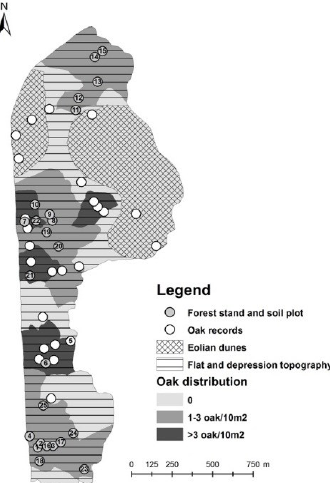
Figure 3. Distribution of study sampling sites and areas with oak saplings within the Vecdaugava forest. The forest floor was generally densely covered with vegetation. The plant communities in gaps were dominated by Calluna vulgaris (L.) Hull, Vaccinium myrtillus L. and Vaccinium vitis-idaea L. (mean 24.0%, 8.4% and 6.5% of gap area, respectively). V. myrtillus and V. vitis-idaea dominated in control plots (mean 16.5% and 10.7%, respectively). Hylocomium splendens (Hedw.) Schimp and Pleurozium schreberi (Willd.ex Brid.) Mitt. (mean 24.5% and 42.0% in gaps and 21.0% and 44.3% in control plots, respectively) were the dominant moss species. The most common graminoid species was Deschampsia flexuosa (L.) (mean 8.0% in gaps and 4.5% in control plots), and the most dominant herb species was Melampyrum pratense (L.) (mean 10.0% in gaps and 9.2% in control plots) . Figure 4 shows a DCA ordination of vegetation data, with vectors indicating significant correlations of species with the axes. The DCA ordination indicates that the gradient from top to bottom can be explained by disturbance, with open sand patches colonized by L. glaucum and lichens on the top of the ordination and denser gaps with C. vulgaris on the bottom . Typical dry pine forest species such as V. myrtillus and H. splendens occurred in communities on the left side of the ordination. On the right side of the ordination D. flexuosa and P. shreberi were more abundant. Gaps with areas ≤100 m 2 were mostly found on the right side of the ordination. Figure 4. Species and plot scores on DCA. Gap class of plots is shown. Abbreviations: Hylocom— Hylocomium splendens ; Vaccmyrt— Vaccinium myrtillus ; Aulapalu— Aulacomnium palustre (Hedw.) Schwägr.; Melamp— Melampyrum pratense ; Dicrpoly— Dicranum polysetum Sw.; Dicrscop— Dicranum scoparium Hedw.; Cladina— Cladina rangiferina (L.) Nyl.; Leucobr— Leucobryum glaucum (Hedw.)